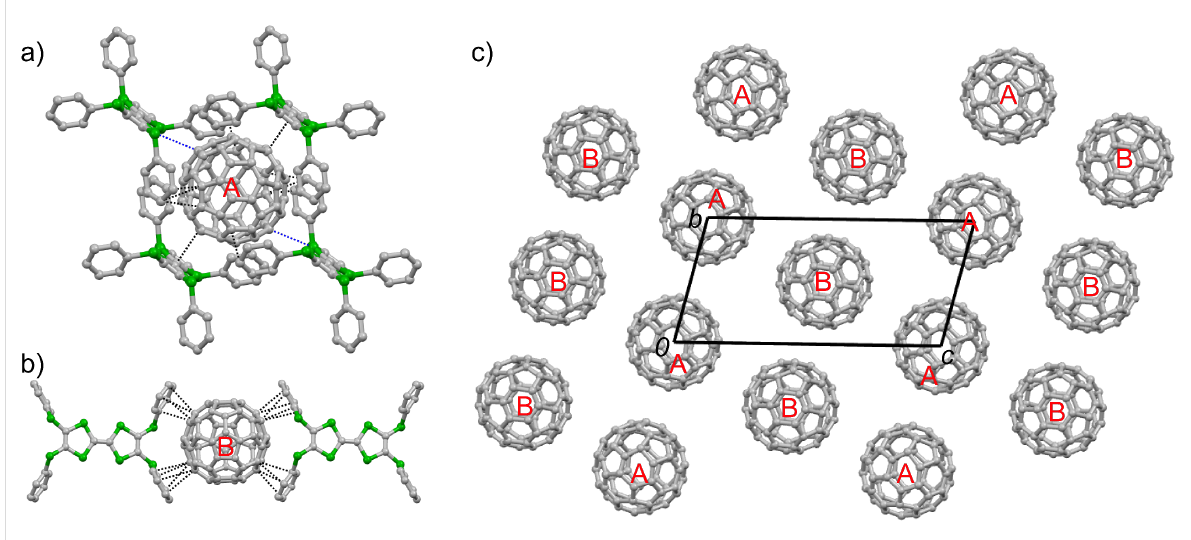
Figure 2: Crystal structure of 1 ·(C 60 ) 2 ·(CS 2 ) 2 . a) Interactions of C 60 molecule A with 1 , where the blue and black dashed lines indicate the C–S and C–C contacts between 1 and C 60 , respectively. b) Interactions of C 60 molecule B with 1 ; c) packing motifs of C 60 , depiction along the a -axis. The hydrogen atoms and solvent molecules are omitted for clarity.